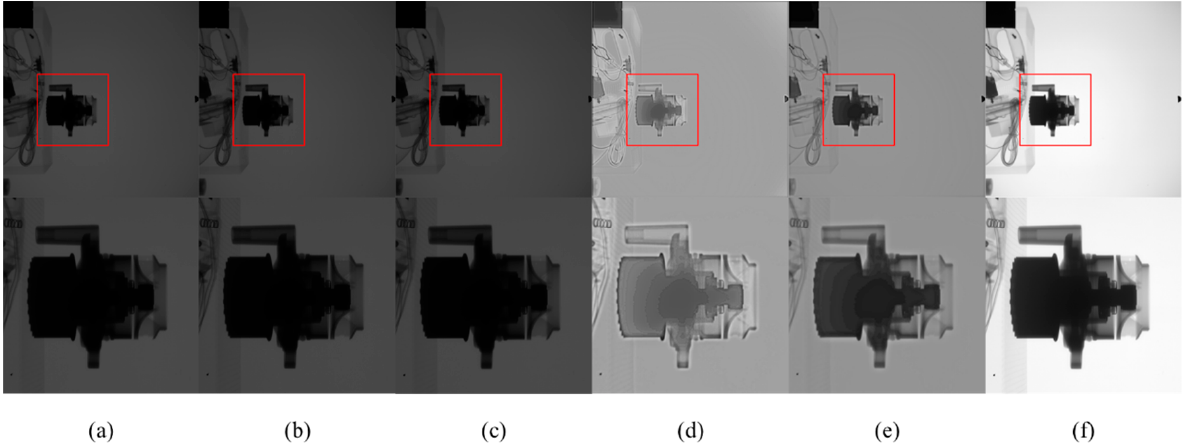
Figure 13. The contrast enhancement results of different methods. Top: raw image and the enhance- ment results; bottom: zoomed-in views on the highlighted area. ( a ) The raw images; ( b ) CLAHE; ( c )